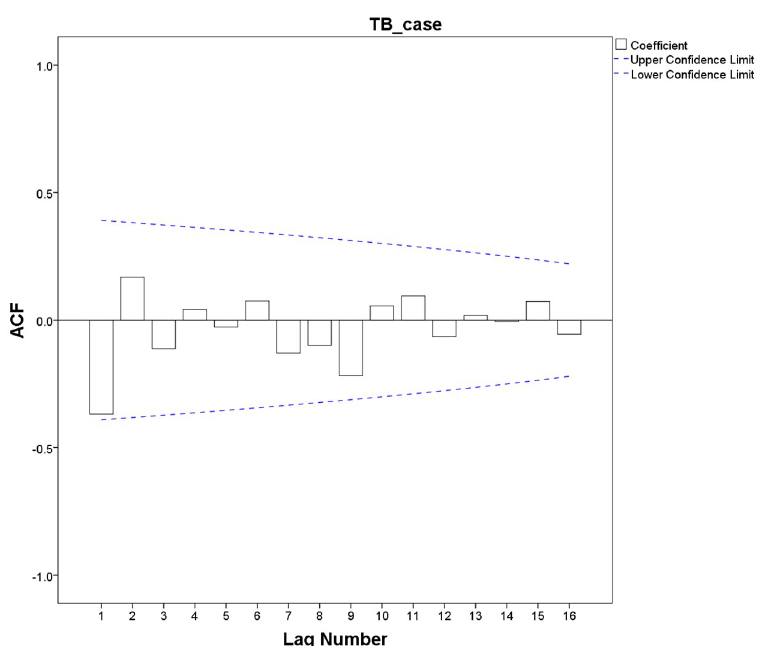
Fig 5. Plot of ACF after a differenced TB cases time